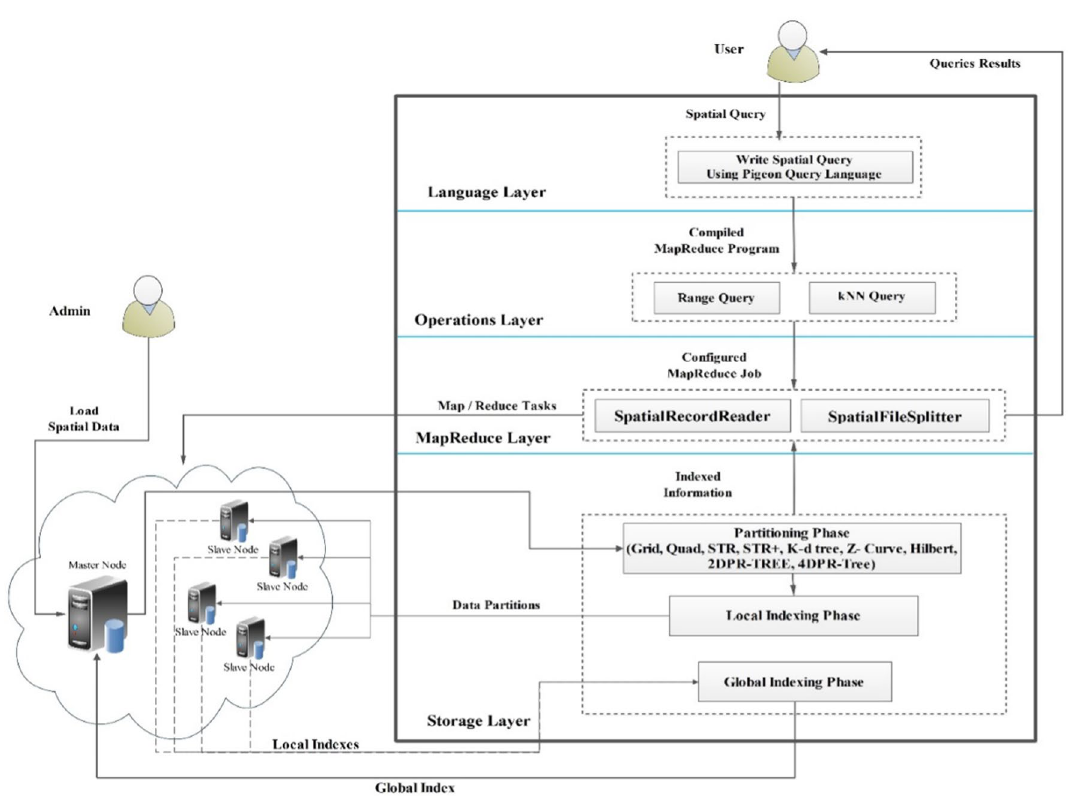
Fig. 1 SpatialHadoop system architecture